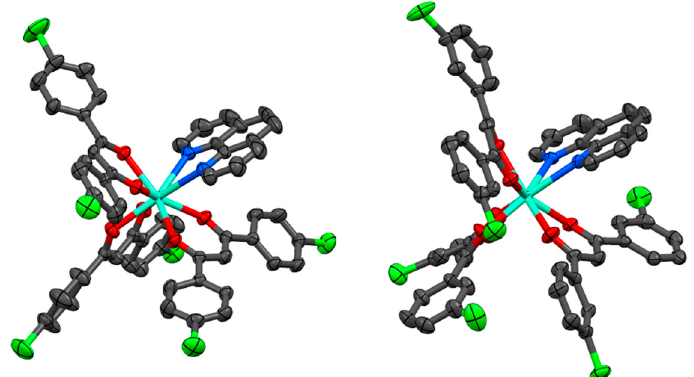
Figure 3. Crystal structures of [Eu( pp -dbm-Cl 2 ) 3 phen] (left) and [Eu( mm -dbm-Cl 2 ) 3 phen] (right) Hydrogen atoms are omitted for clarity. Thermal ellipsoids are drawn at 50% probability. Color code: cyan (Eu); red (O); blue (N); green (Cl); and black (C).